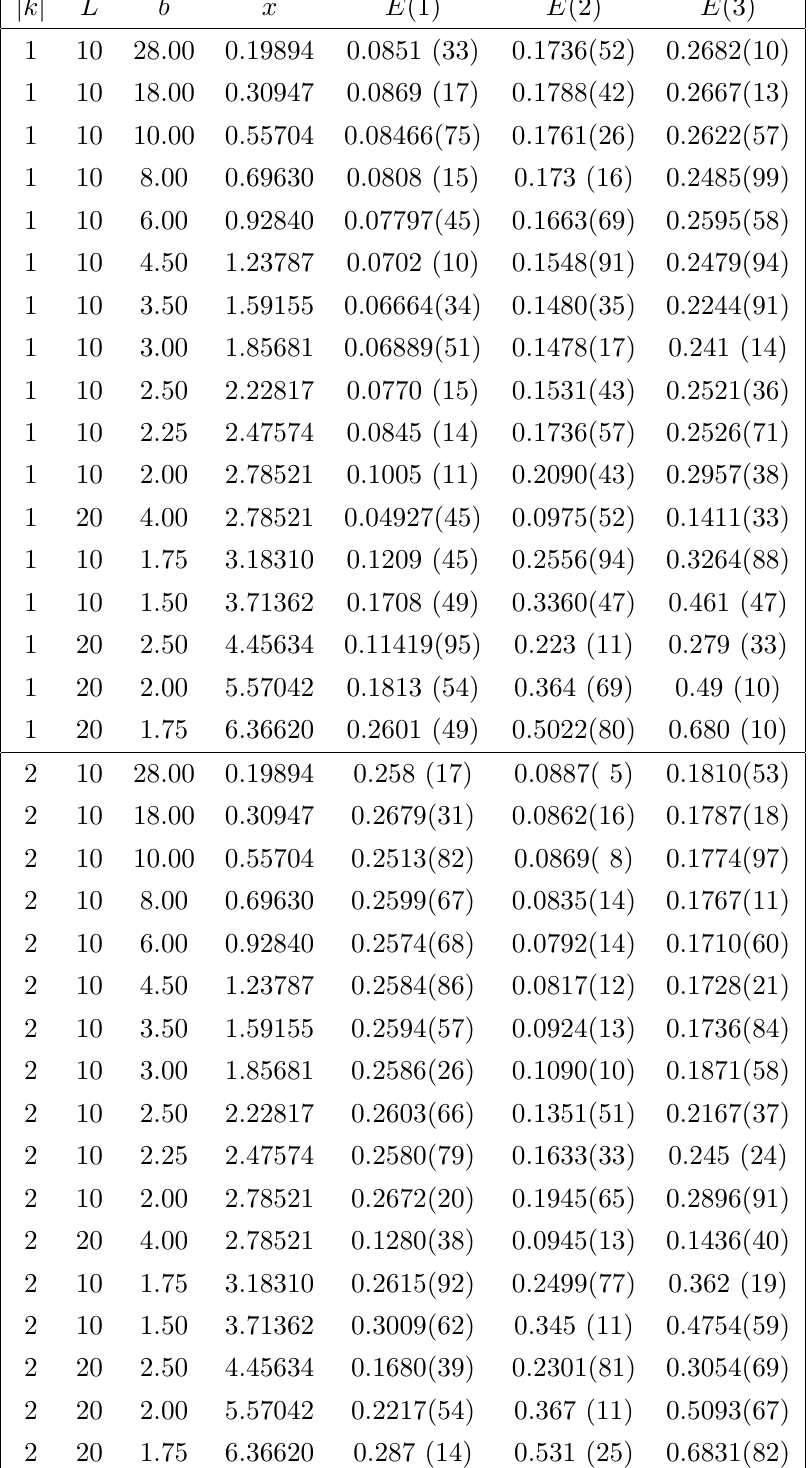
Table 4. SU(7) torelon energies (in lattice units). The states are labeled by the value of the electric (cid:13)ux